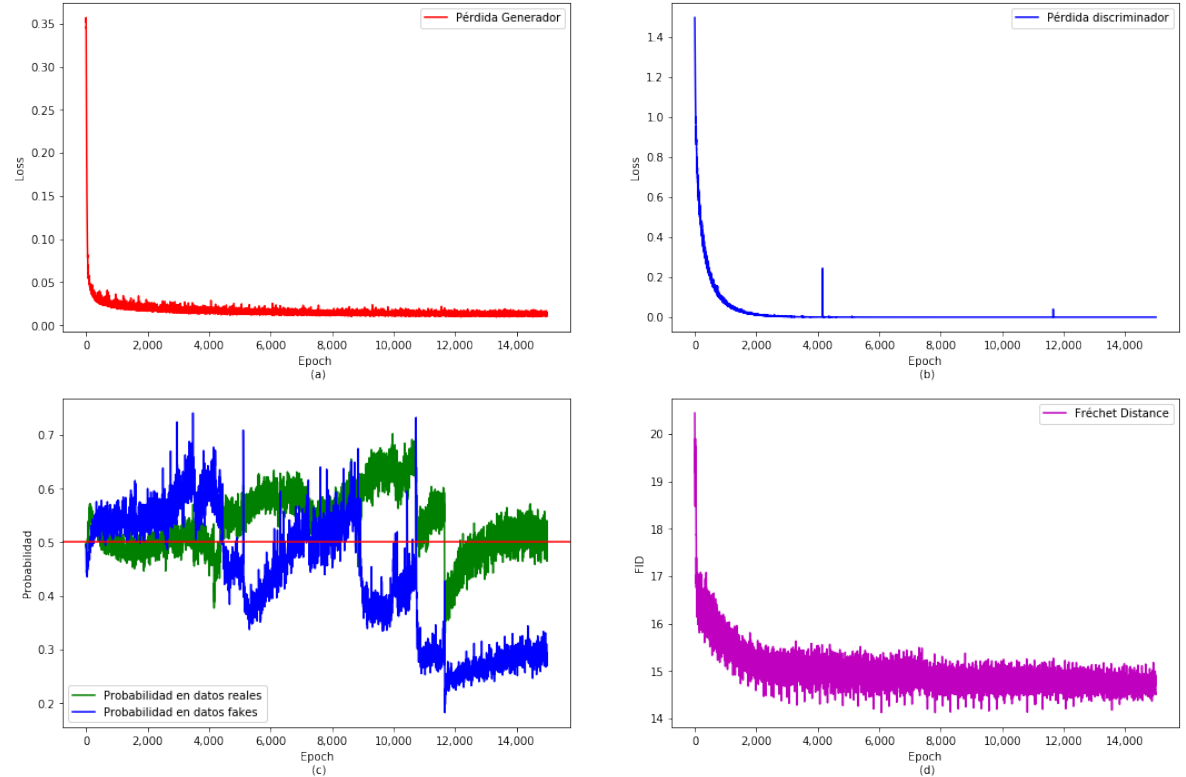
Figure 3. Training results for the implemented GAN architecture. Losses ( a , b ), Accuracy on real and synthetic data ( c ) and Fréchet distance ( d ) are